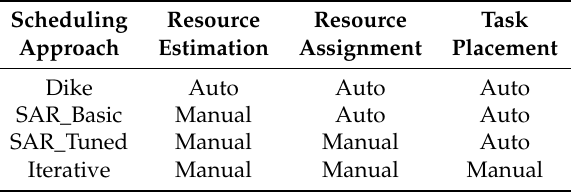
Table 1. Overview of different resource